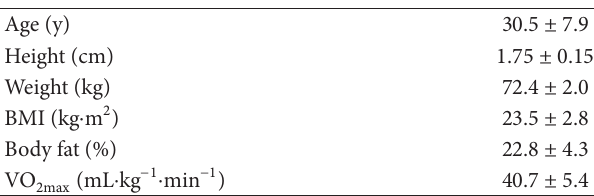
Table 1: Participant characteristics.